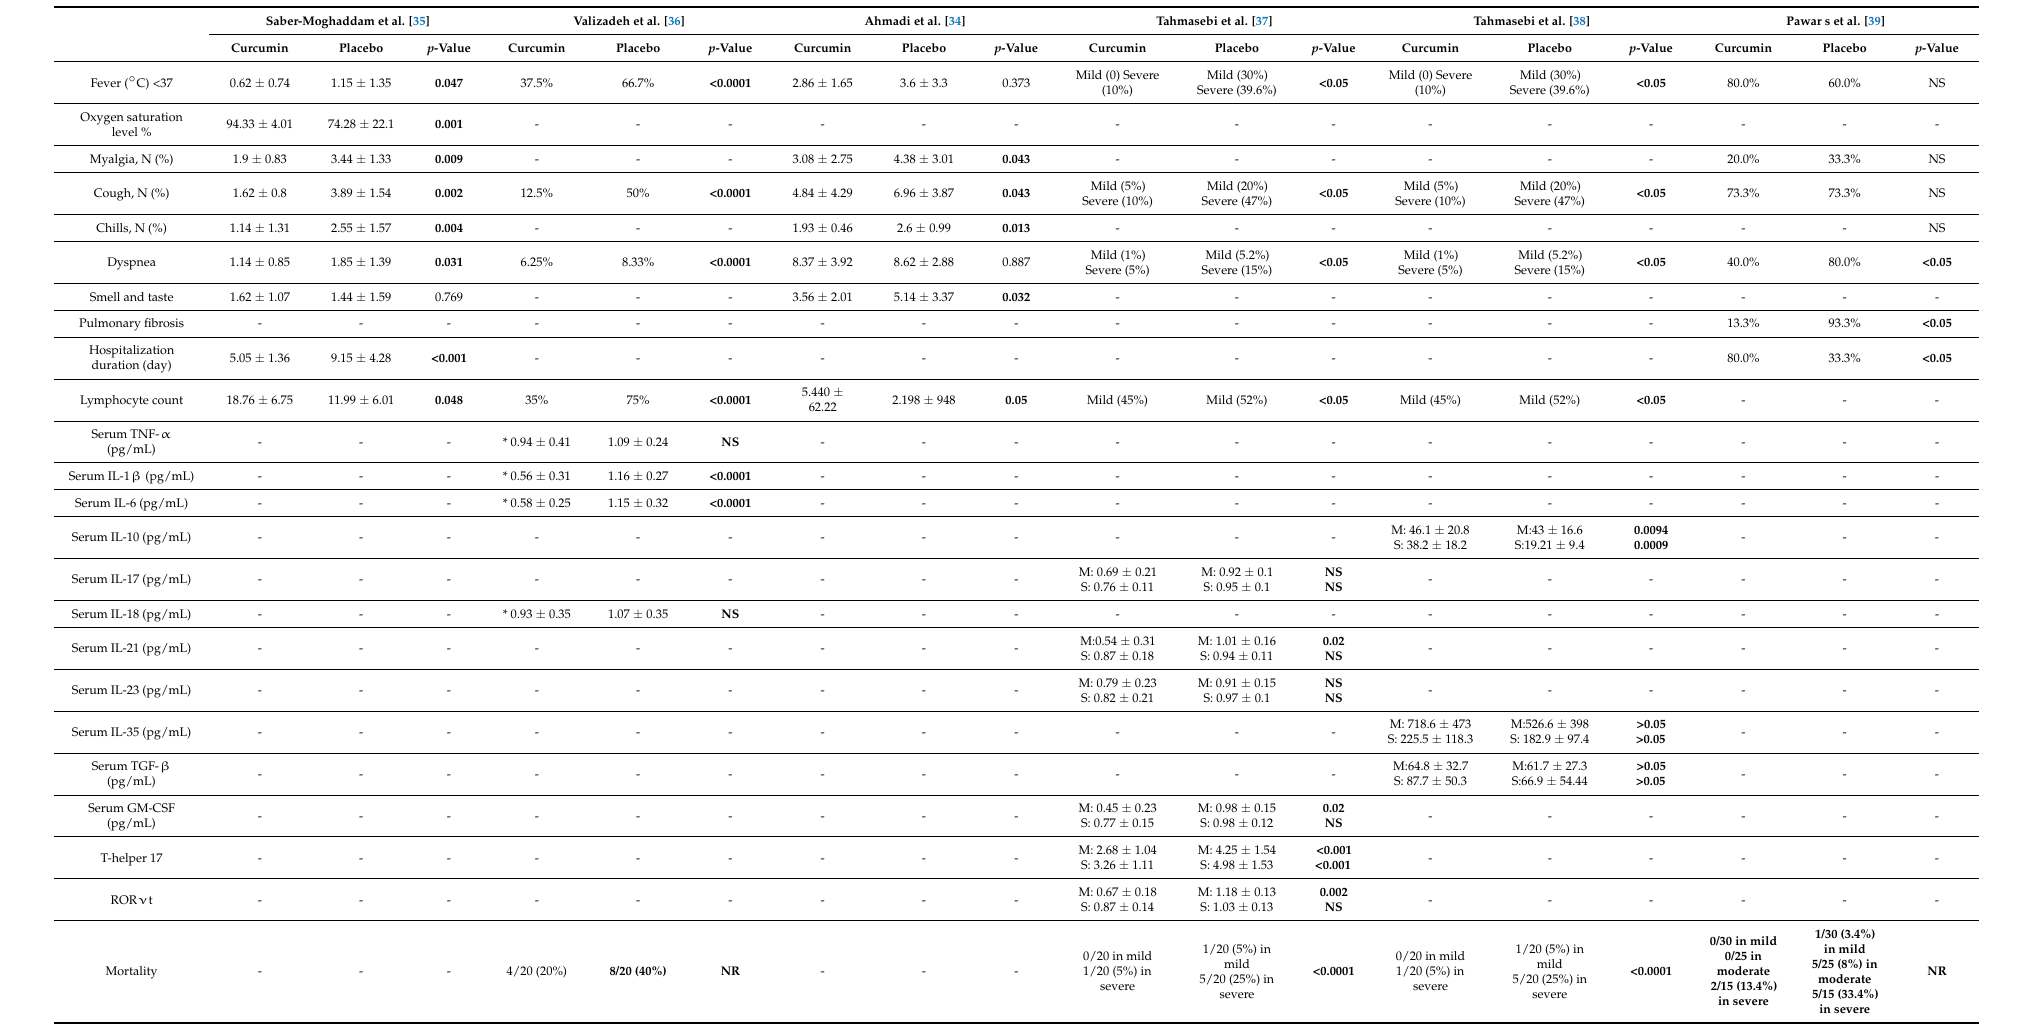
Table 2. The main clinical and laboratory findings in the included studies.